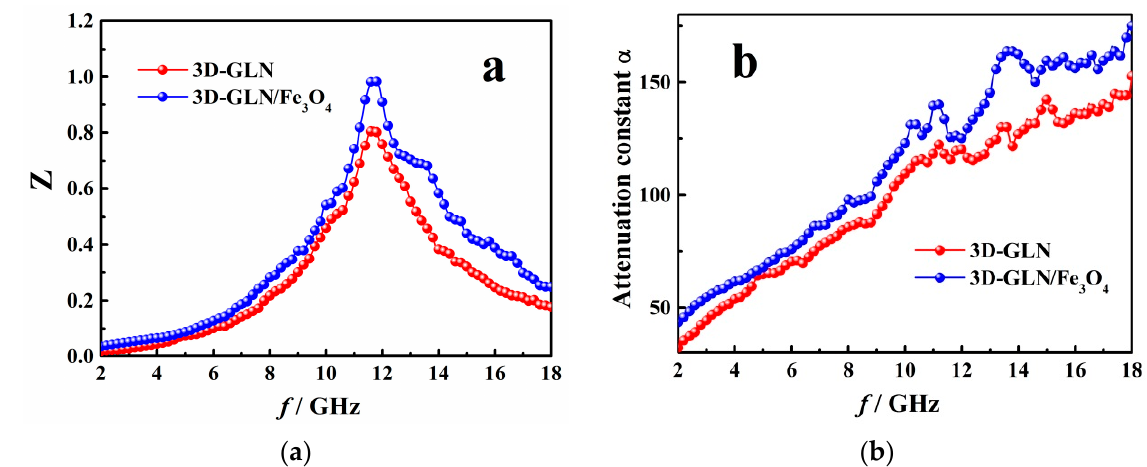
Figure 10. Frequency dependence of Z ( a ) and α ( b ) for the 3D-GLN and the 3D-GLN/Fe 3 O 4 .